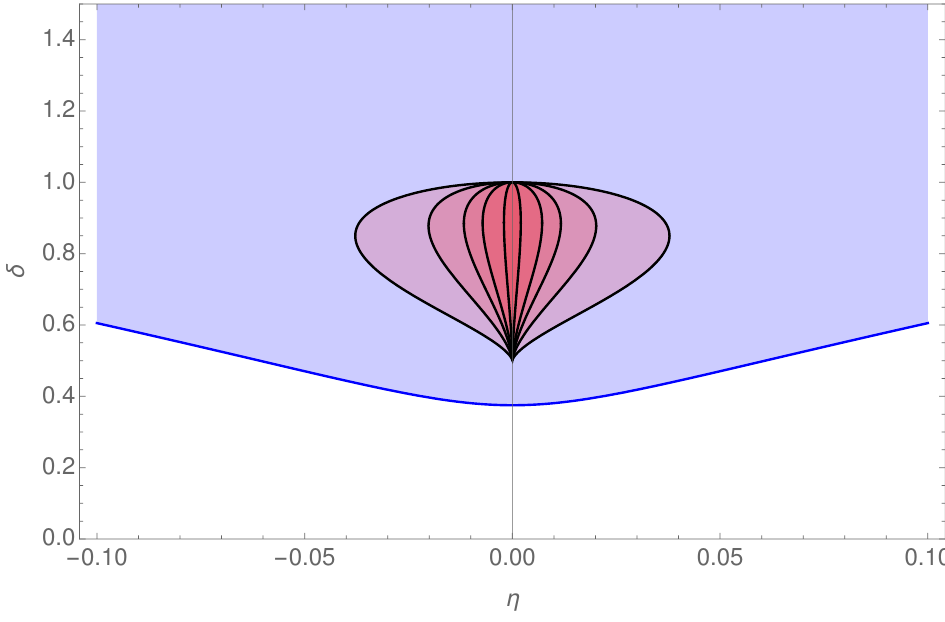
Figure 4 . The red regions are where (cid:9) (1 ; 3) (cid:0) c(cid:13) (cid:9) (0 ; 1) > 0; modular invariance implies the existence of an operator in each of these regions for any value of (cid:13) . The regions become narrower as (cid:13) is increased. The blue region is the unitarity bound set by the positivity of the Kac matrix. This is a stronger constraint than the one in (cid:12)gure 3.